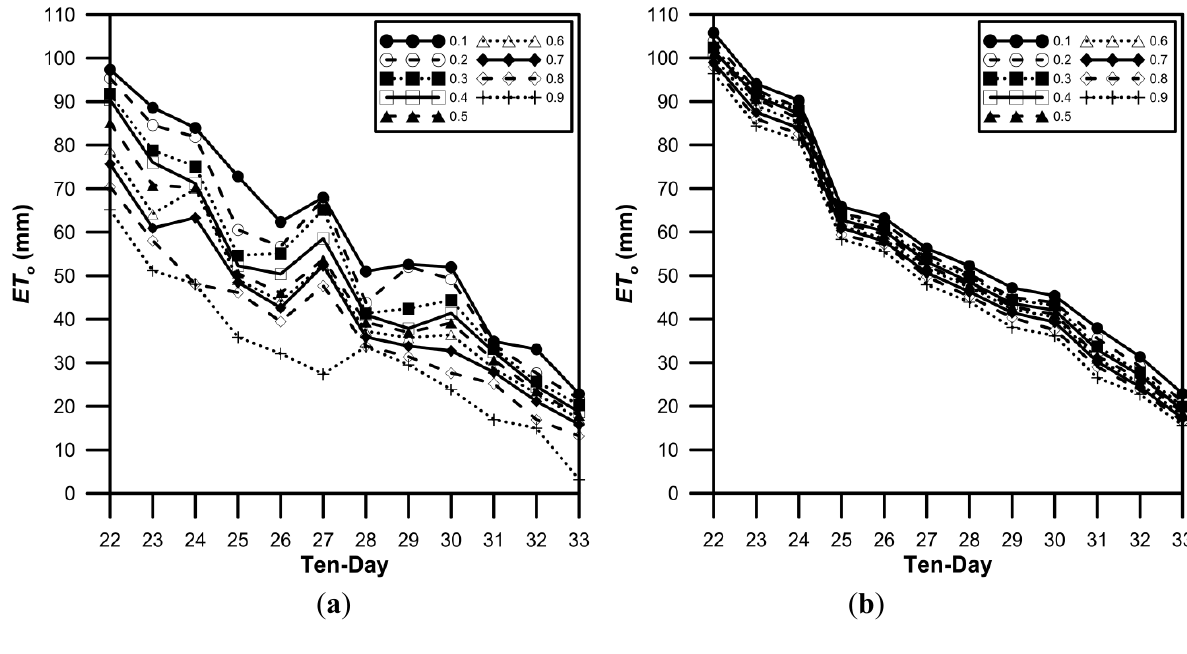
Figure 10. Exceedance probability distribution of evapotranspiration at each ten-day during the second cropping season. ( a ) present (2004–2011); ( b ) future